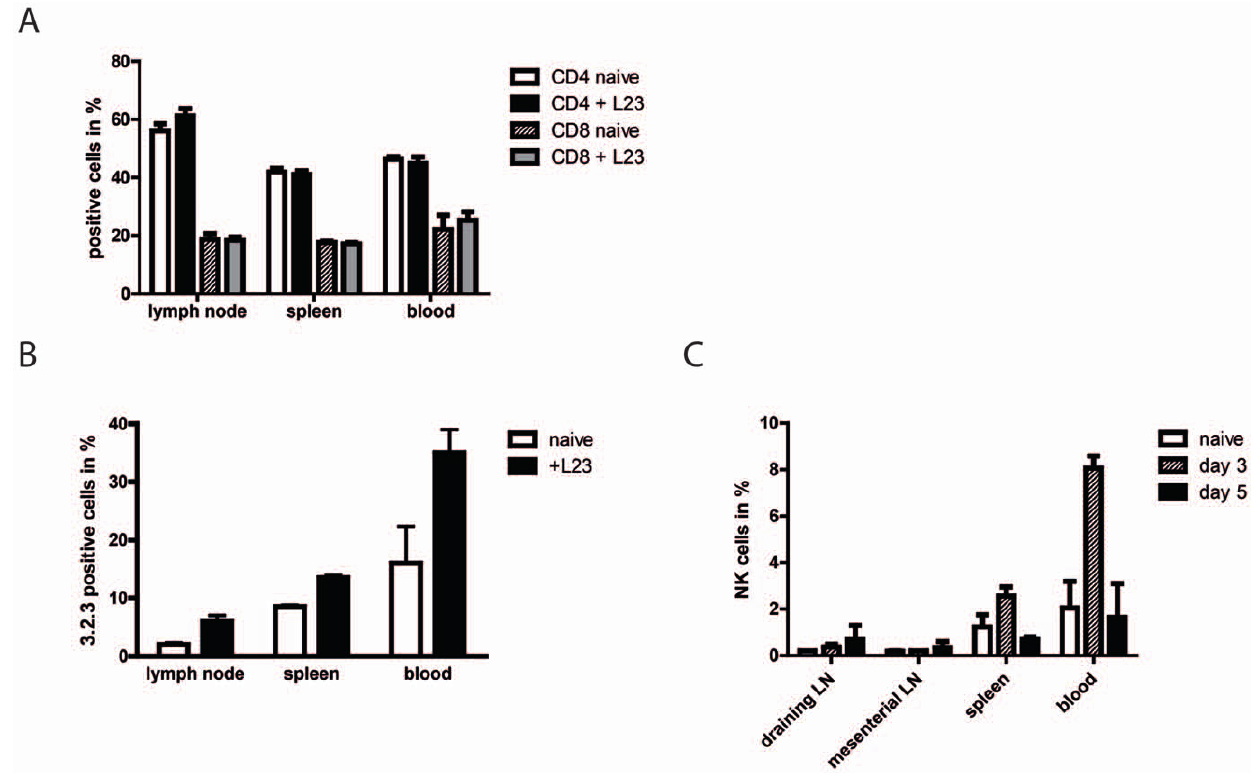
Figure 3. NK cells infiltrate the draining lymph nodes and expanded proportion in spleen and blood in the early phase of immune response. A: Analysis of CD4 + and CD8 + T cells in draining cervical lymph nodes, spleen and blood revealed unaltered percentages in naive and transplanted Lewis rats. B: Percentages of 3.2.3 + cells in draining cervical lymph nodes, spleen and blood of Lewis wt rats, naive or 3 days post transplantation of L23 ( + L23). In contrast to T cells the increase of 3.2.3 + cells indicated infiltration and expansion of NK cells and/or monocytes. C: Staining with mAb 3.2.3 of lymph nodes, spleen and blood of LEW.BH-NKC identified NK cells in naive rats or at different time points after transplantation of L23 cells. Detection of NK cells confirmed the increase in draining lymph nodes, spleen and blood at the early phase of immune response. The comparison of draining lymph node cells with population of mesenterial lymph nodes revealed a weak increase of NK cells. Results are shown as graphs summarising results of at least three independent experiments as mean 6 standard deviation.